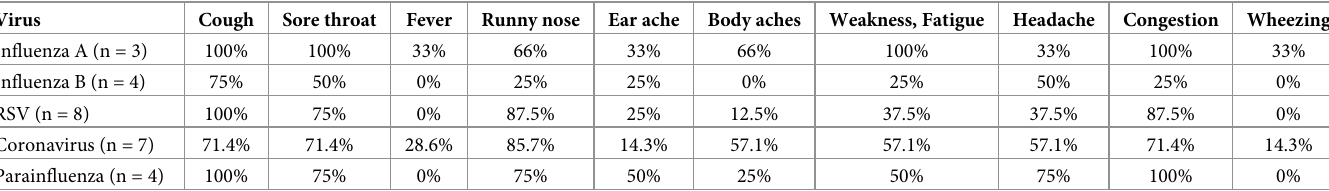
Table 4. Symptoms the individuals were experiencing at the time of the clinic visit for the 5 most common viruses detected in this study using RNA